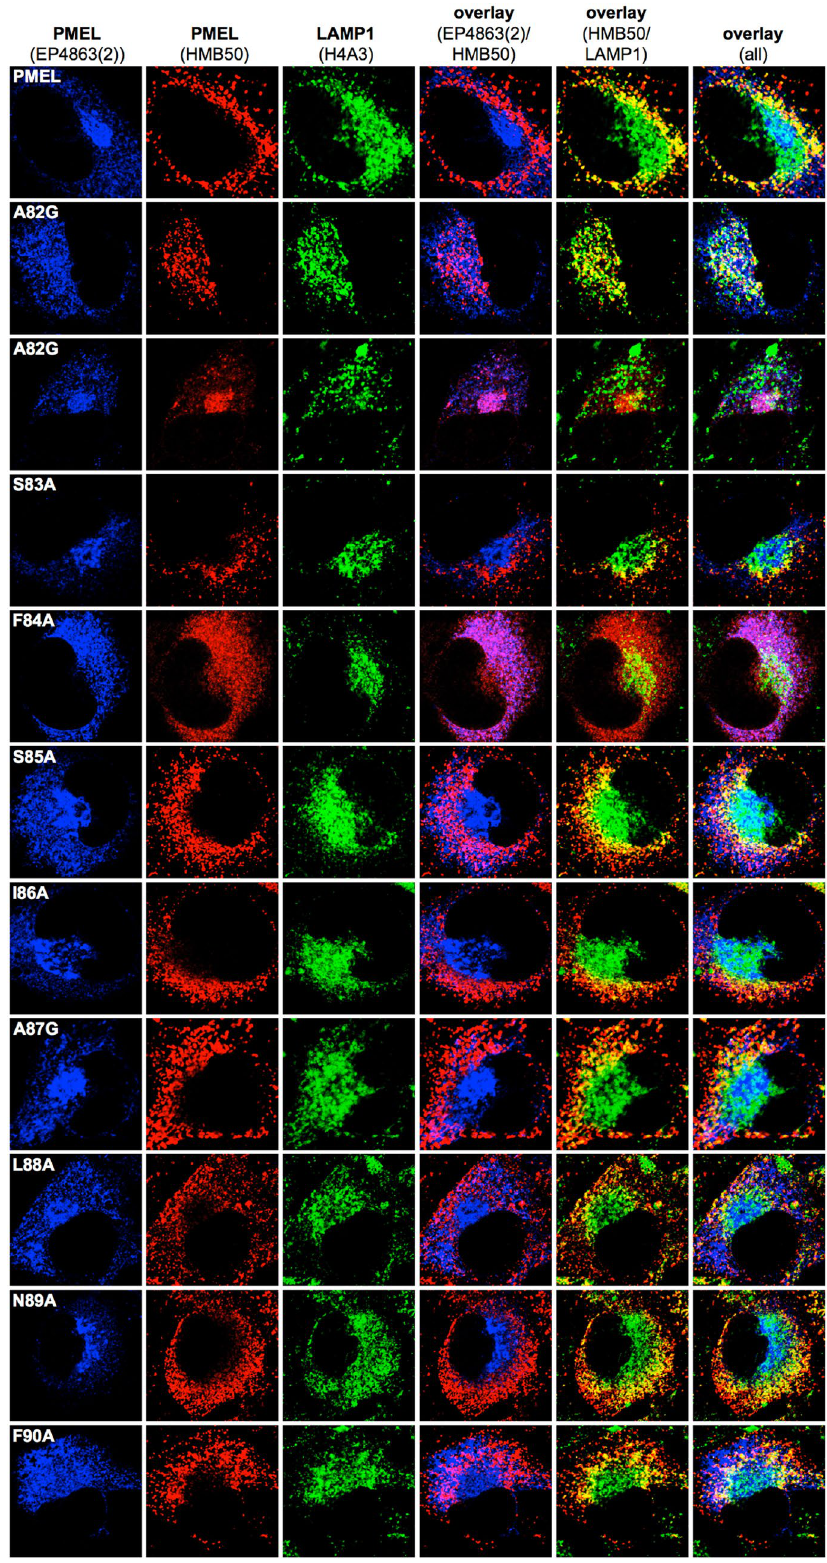
Figure 3. Subcellular trafficking and melanosome-lysosome segregation of PMEL alanine-scanning mutants. Immunofluorescence analysis of Mel220 cells stably expressing PMEL alanine-scanning mutants. The antibody EP4863(2) recognizes newly synthesized, but not fibrillar PMEL. The PMEL-specific antibody HMB50 recognizes mature melanosomal fibrils. The LAMP1-specific antibody H4A3 recognizes a lysosomal marker. Note that proper PMEL amyloid formation typically correlates in this assay with a significant separation of the perinuclear lysosomal staining (LAMP1) from the largely peripheral melanosomal staining